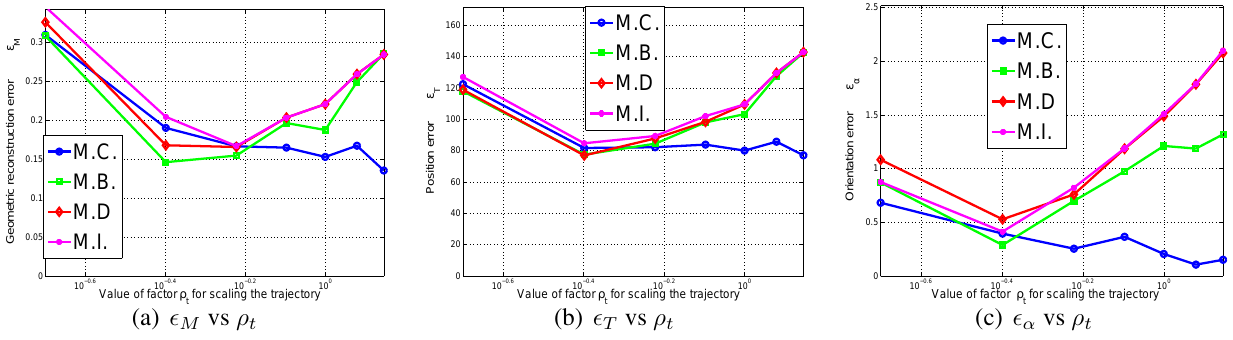
Figure 10. Experiment showing the different initialization errors in function of the trajectory length performed by the robot.